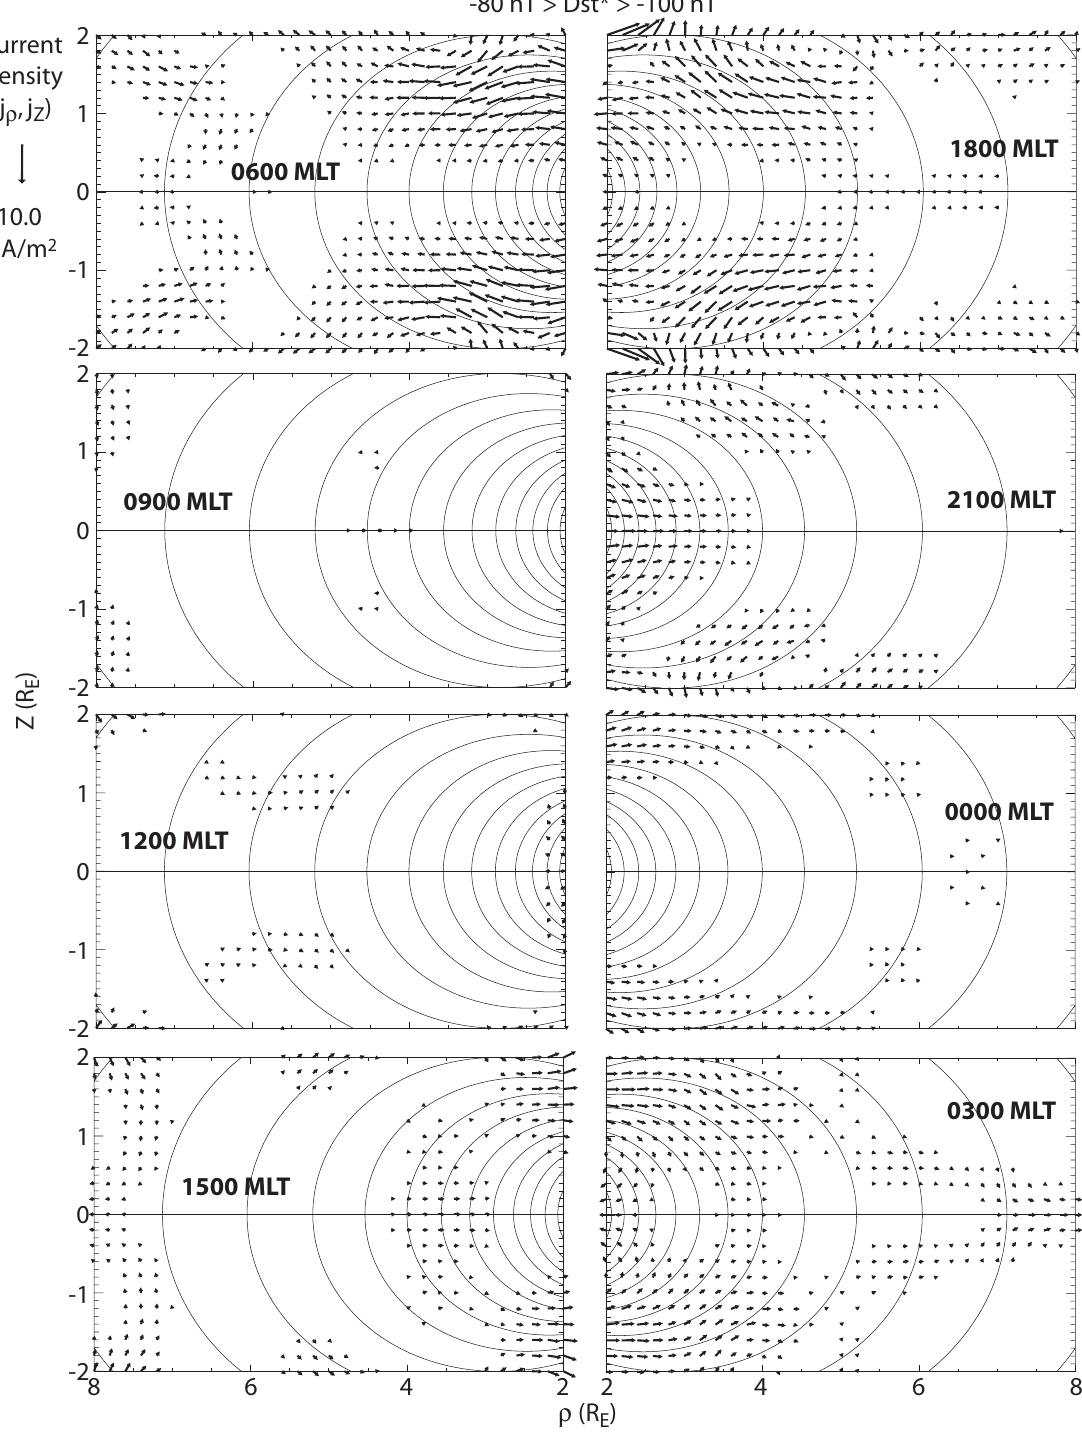
Fig. 10d. Meridional components of the current density as arrows in equally spaced grids in each of the 8 local time planes with su- perimposed dipole field lines for the four D st * levels. The scale factor for the current density is different for different D st * level. (d) − 80nT >D st * > −